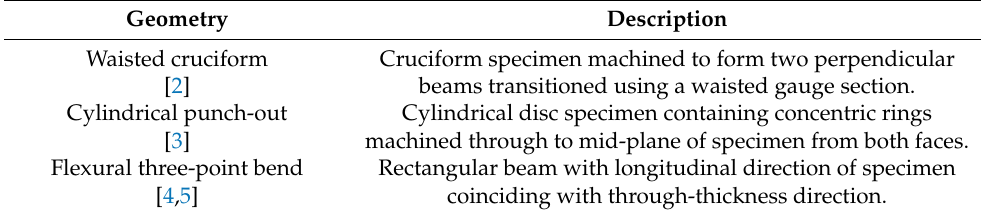
Table 1. Summary of indirect test